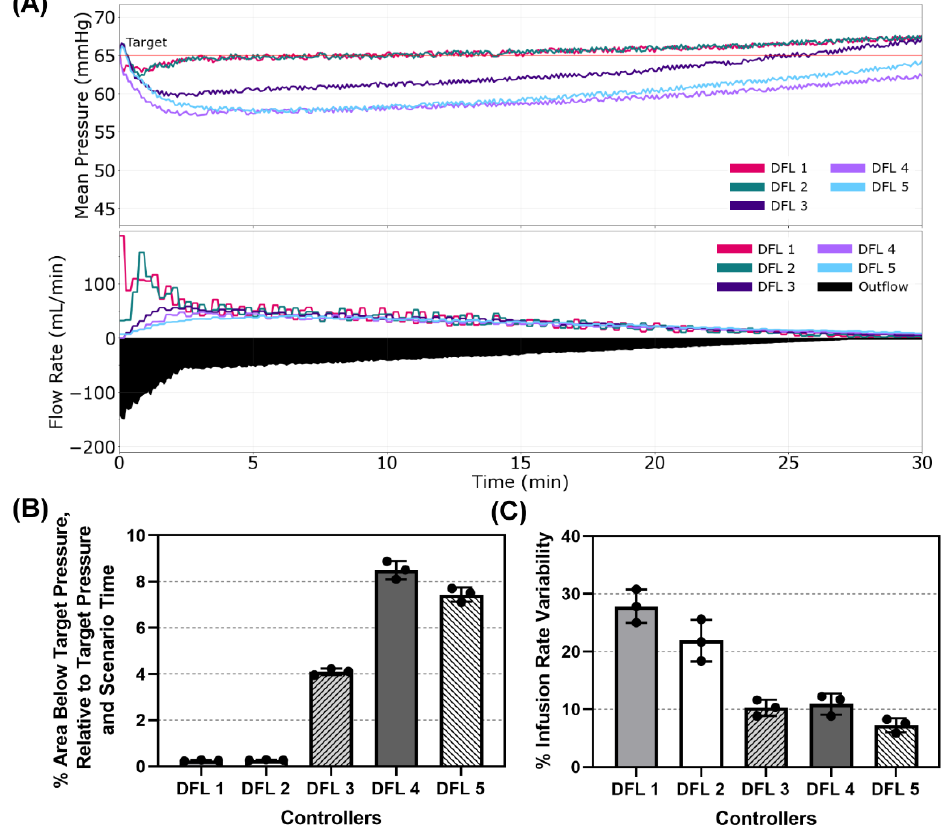
Figure 5. Dual-input fuzzy logic results for Scenario 2. Scenario 2 began with a MAP of 65 mmHg with an active hemorrhage that slows with time to mimic coagulation for 30 min, with a resuscitation target of 65 mmHg. ( A ) Five controller designs’ MAP and infusion rate vs. time are shown for one replicate run. A single representative outflow vs. time result is shown. ( B ) Area below target pressure and ( C ) infusion rate variability performance metrics for each controller design are shown as mean values from three subject variability runs, with error bars denoting standard deviation.